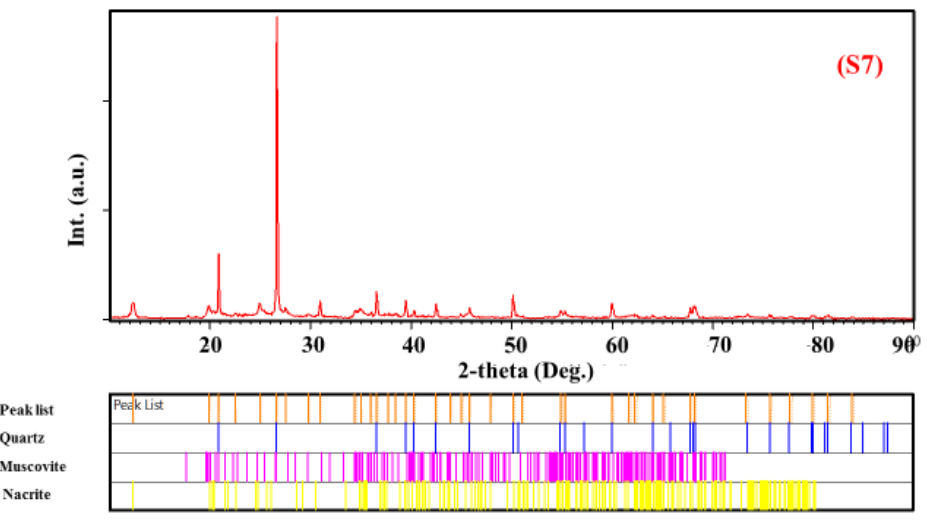
Figure 2. Rietveld refinements of XRD patterns of (S1) green-yellow clay—Adrar, (S2) green clay— Adrar, (S3) red clay—Adrar, (S4) red clay—Reggan, (S5) white clay—Reggan, (S6) white-red clay— Reggan, and (S7) red clay—Timimoune. Table 2. Crystallographic parameters and properties of different phases used for the Rietveld